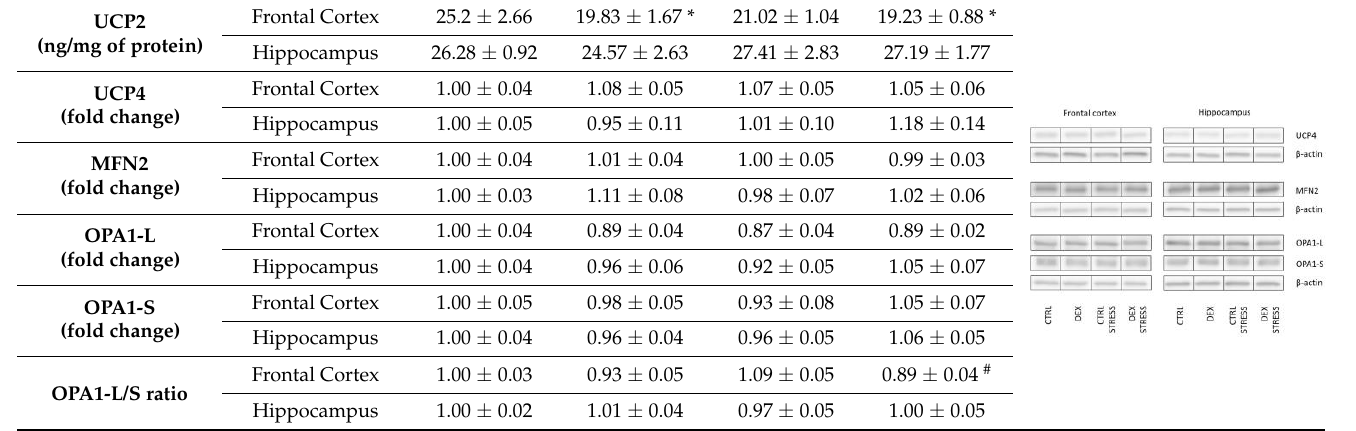
Figure 11. The effects of DEX treatment and acute stress on the levels of phospho-Akt (pAkt/Akt) and total Akt in the tissue homogenates of the frontal cortex ( A , C ) and the hippocampus ( B , D ); proteins levels were determined with Western blotting analysis; * p < 0.05, n = 9 – 10. The results are expressed as the average fold change ± SEM. Statistics: two-way ANOVA, followed by the Duncan test. Table 1. The effects of DEX treatment and acute stress on the levels of UCP2, UCP4, MFN2, OPA1-L, OPA1-S and their ratio in the mitochondria-enriched fraction of the frontal cortex and the hippocampus; proteins levels were determined with ELISA or Western blotting analysis; * p < 0.05 vs. Control group, # p < 0.05 vs. Control Stress group, n = 8–9. The results are expressed as the mean ± SEM or average fold change ± SEM. Statistics: two-way ANOVA, followed by the Duncan test.